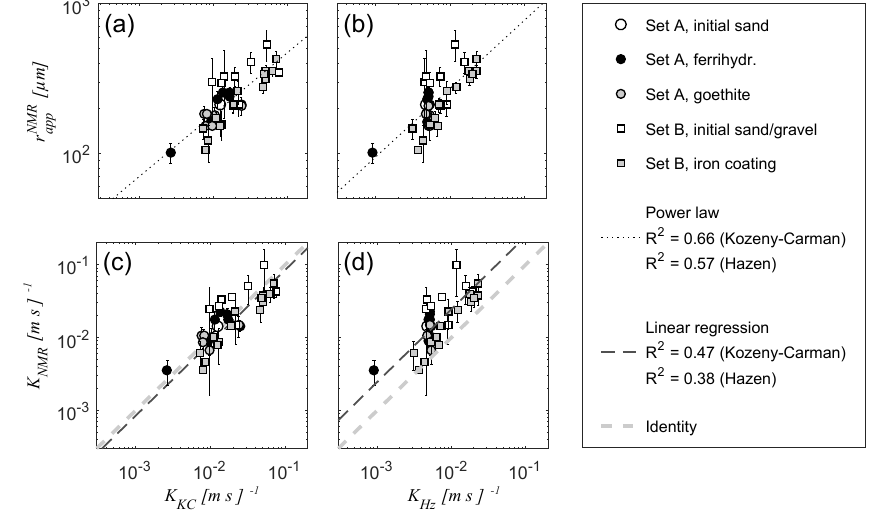
Figure 9. Correlation of NMR-based estimates of apparent radius r NMR app (a, b) and hydraulic conductivity K NMR (b, c) with reference values for hydraulic conductivity, which are estimated from grain size distribution according to (a, c) Kozeny (1927) and Carman (1939) and (b, d) to Hazen